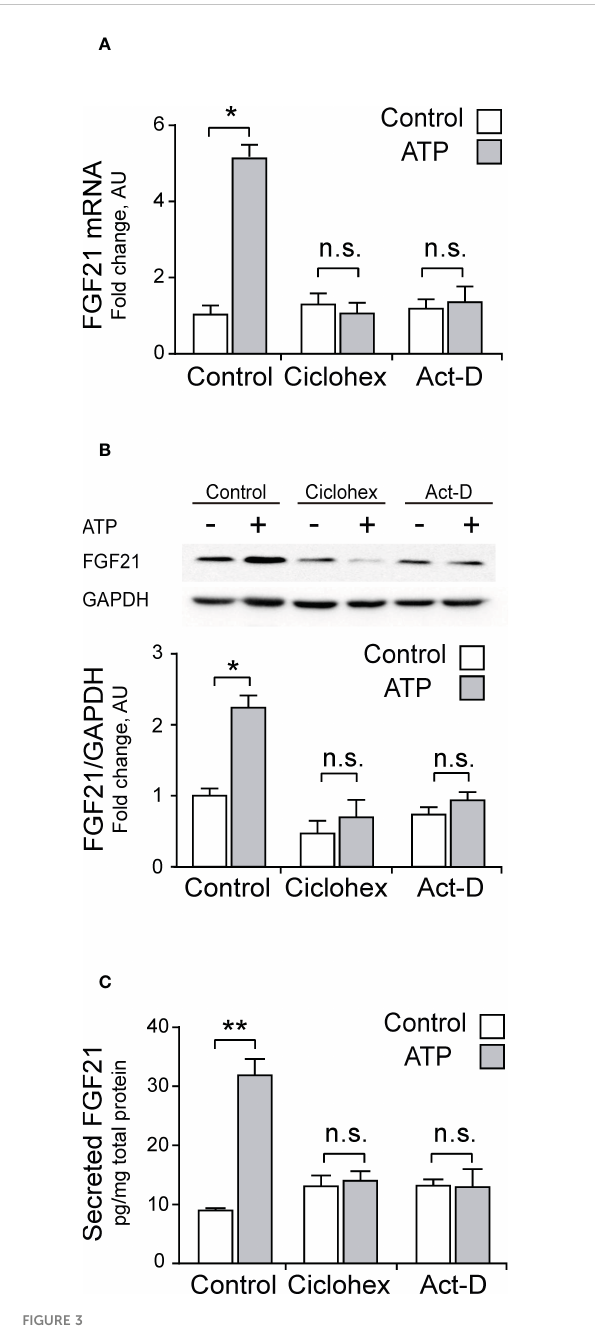
FIGURE 3 ATP stimulation increases FGF21 secretion, protein content, and mRNA levels in whole-FDB muscle, through a transcription- mediated mechanism. Cycloheximide (30 m M; Ciclohex), a general translation inhibitor, and Actinomycin-D (0.5 m M; Act-D), a general transcription inhibitor, both abolished the effect of 3 m M ATP stimulation over mRNA (A) , protein (B) , and secreted (C) FGF21 levels. n=4; n.s., not signi fi cant; *p<0.05, **p<0.01 vs non-ATP Control; Mann-Whitney